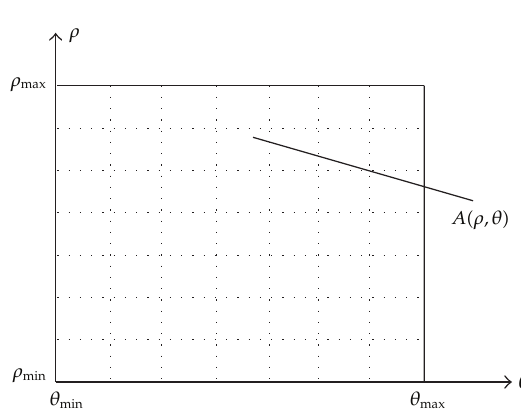
Figure 4: Accumulate array M (cid:2) ρ , θ ) in the parameter map of (cid:2) ρ , θ (cid:3) .